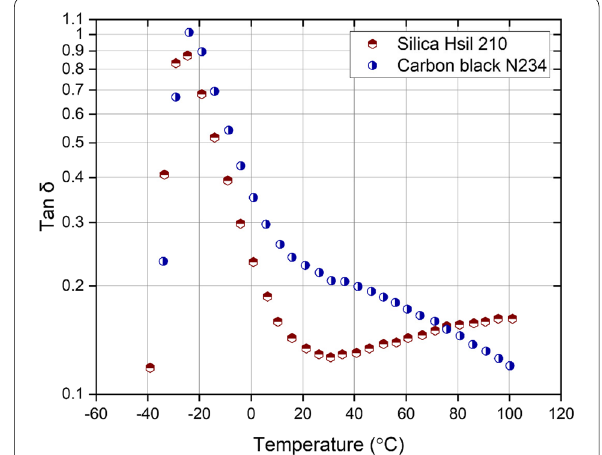
Fig. 4 Temperature dependence of tan δ for vulcanizates filled with carbon black and silica without a coupling agent